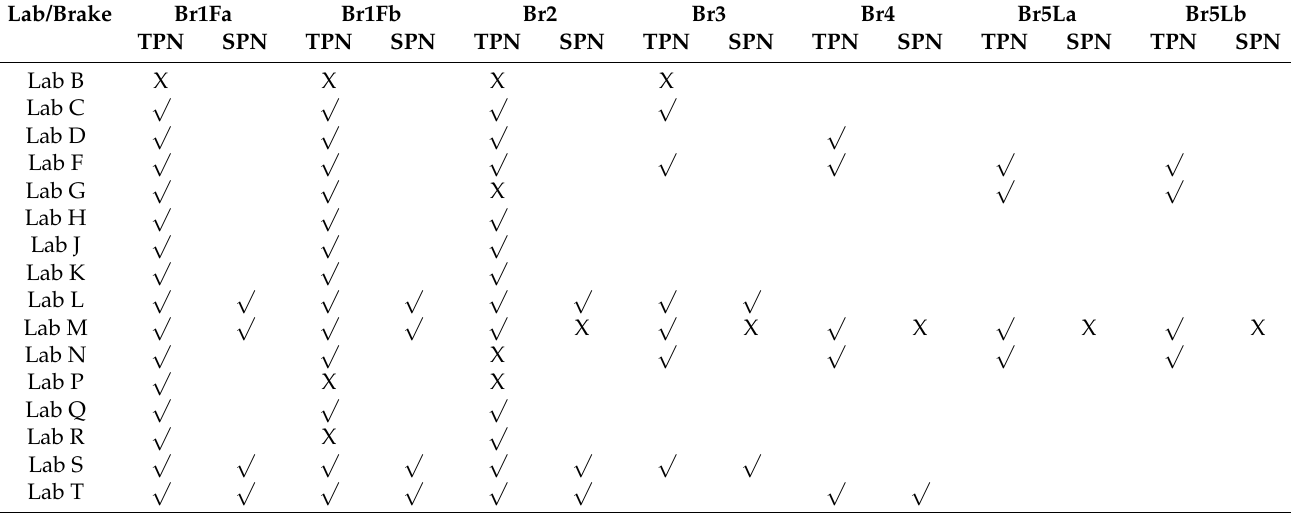
Table 3. Final execution status of the ILS test matrix concerning PN measurements ( X = did not report).